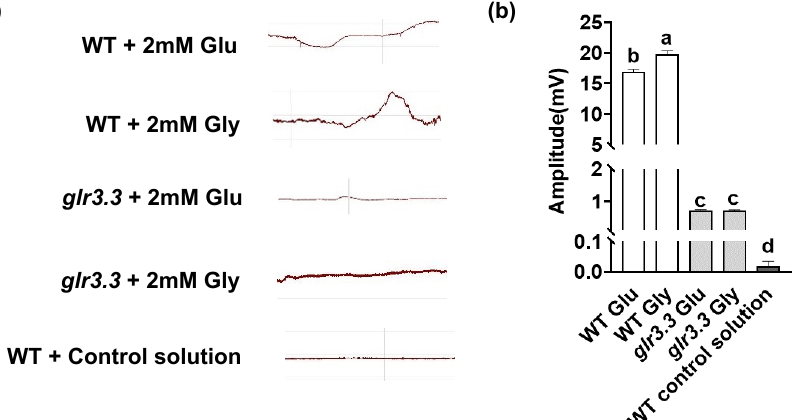
Figure 4. Glu or Gly affects the membrane potential of WT and glr3.3 leaves: ( a ) typical membrane potential changes in tomato WT or glr3.3 mutant leaves treated with Glu or Gly; ( b ) quantification of membrane potential changes of amplitude. The results in panel ( b ) are presented as mean values ± SD; n = 4. Statistically significant differences between treatments ( p < 0.05, Tukey’s test) are shown by different letters. The experiments described above were carried out three times, with the same findings each